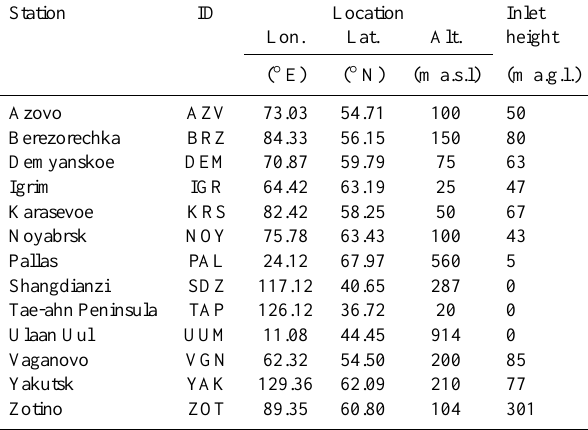
Table 2. Eurasian site characteristics (Sect. 5.3). The altitudes of the sites are given as metres above sea level (a.s.l.) and the inlet height is in metres above ground level